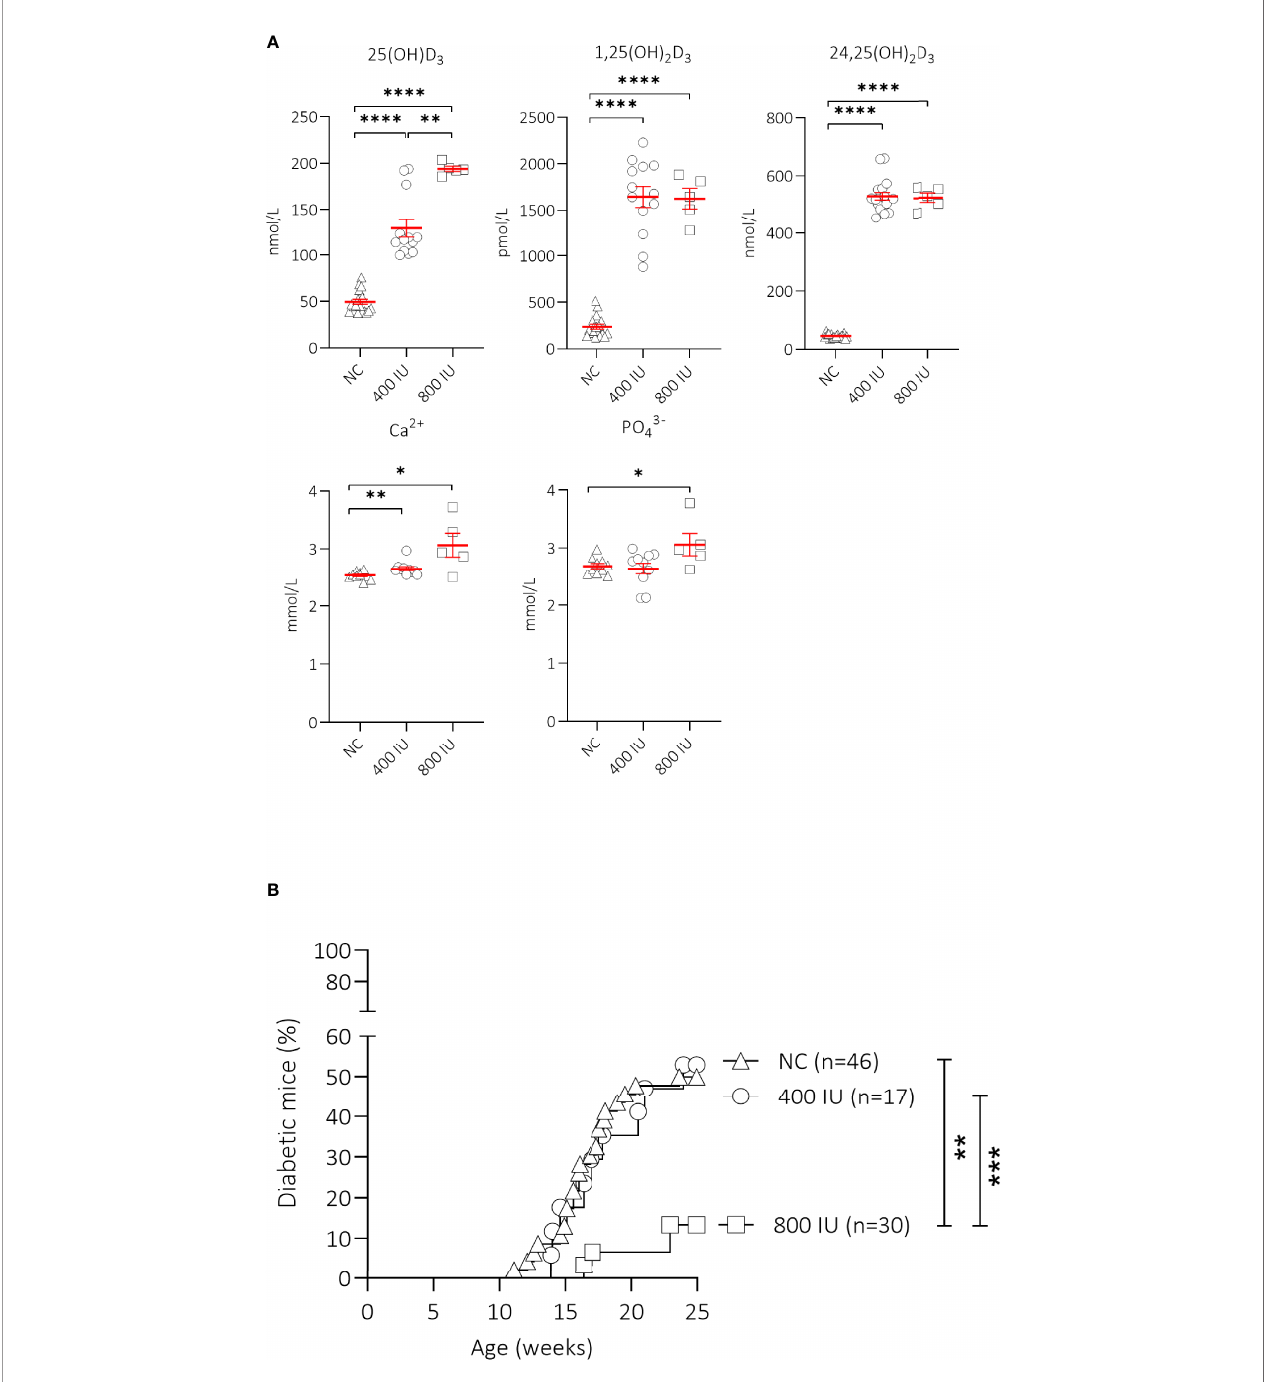
FIGURE 1 | Effect of vitamin D substitution regimen on serum metabolites and type 1 diabetes (T1D) incidence. NOD mice were fed normal chow (NC) or two different doses of vitamin D-supplemented (400 or 800 IU/day) diet from 3 until 25 weeks of age. Serum levels of 25(OH)D 3 , 1,25(OH) 2 D 3 , 24,25(OH) 2 D 3 , calcium, and phosphate are shown for NOD mice of 8 weeks of age (5 weeks on the respective diets). Symbols represent individual mice (N = 5-18), and the line re fl ects the group mean with SEM. (A) Kaplan-Mayer survival curves depict T1D incidence over time. Mice (N = 17-46) with two consecutive measurements of blood glucose values >200 mg/dL were considered diabetic. (B) . *P ≤ 0.05; **P ≤ 0.01; ***P ≤ 0.001; ****P ≤